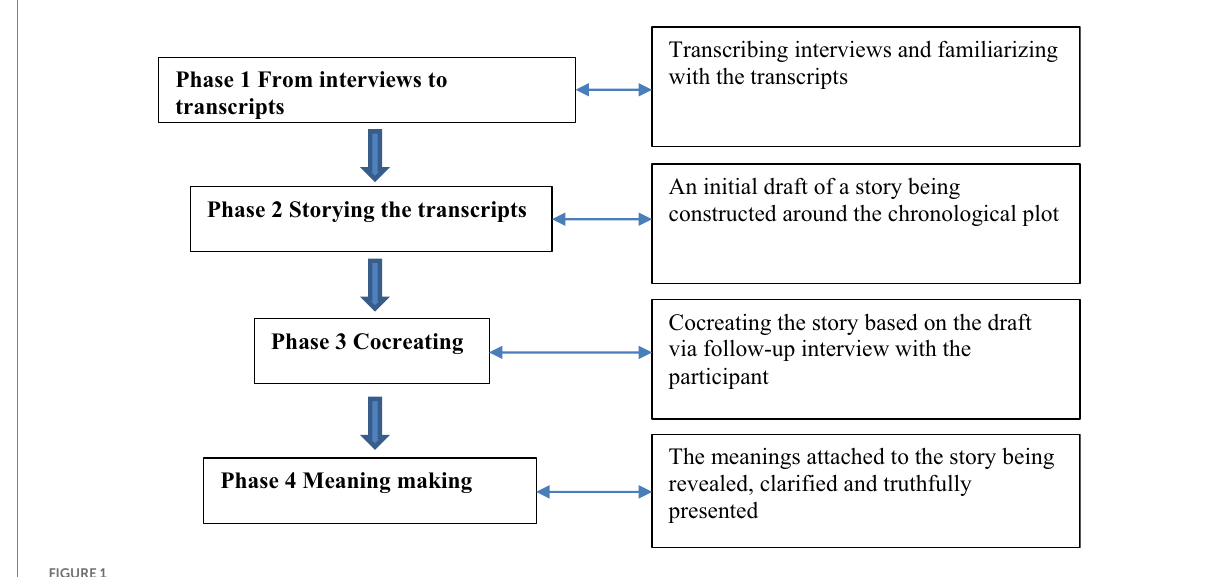
FIGURE 1 A four-phrase framework for constructing the